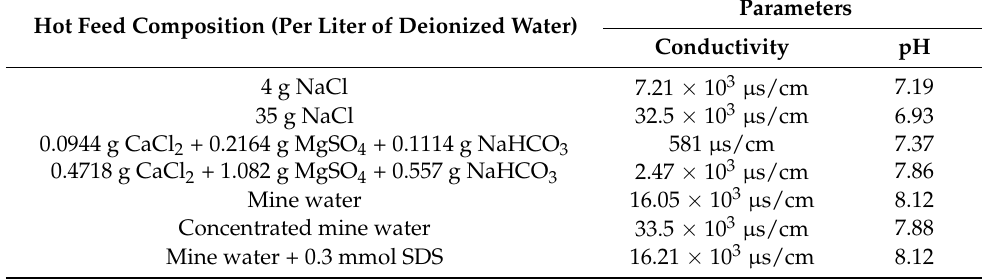
Table 2. Experimental water and water quality parameters.